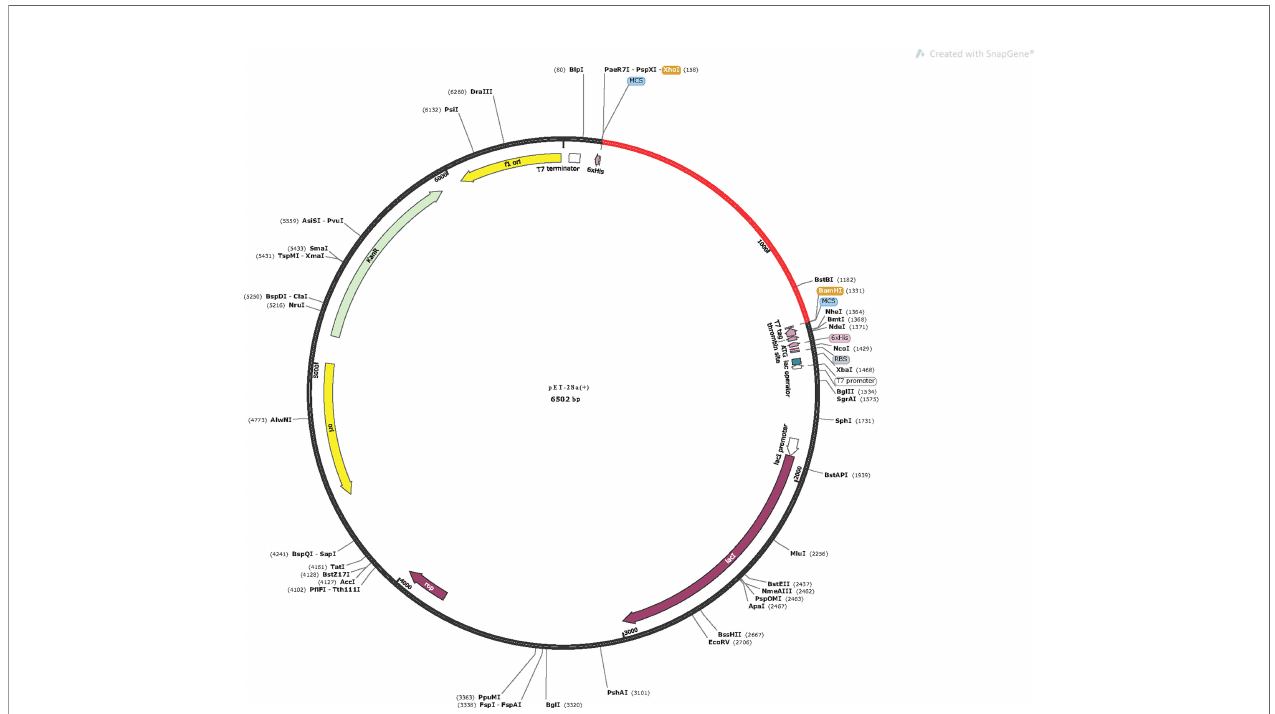
FIGURE 10 | In silico cloning of the vaccine in the pET28a(+). Red area represents the optimized nucleotide sequence of the vaccine, the black areas represent the expression vector, pET28a(+), the XhoI and BamHI represent the cleavage sites of the restriction